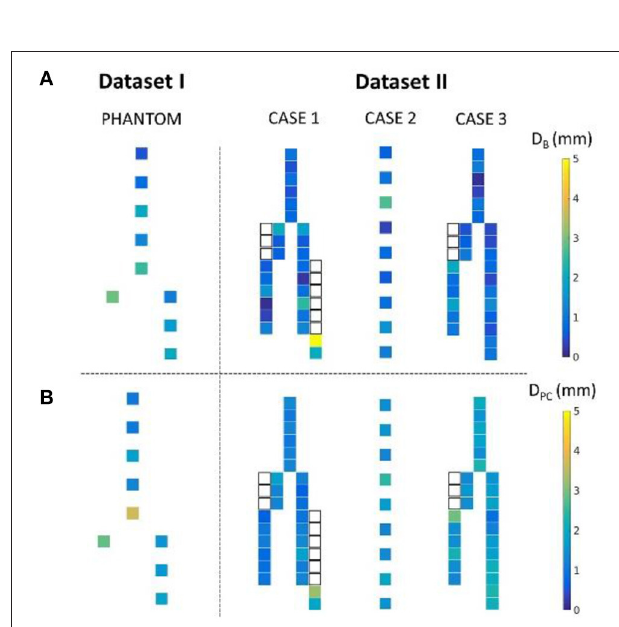
FIGURE 10 | Distance map representing the distance D B (A) and D PC (B) for the phantom and the three patient cases. The white squares represent the stents of the legs overlapped with the main body stents, not included in the